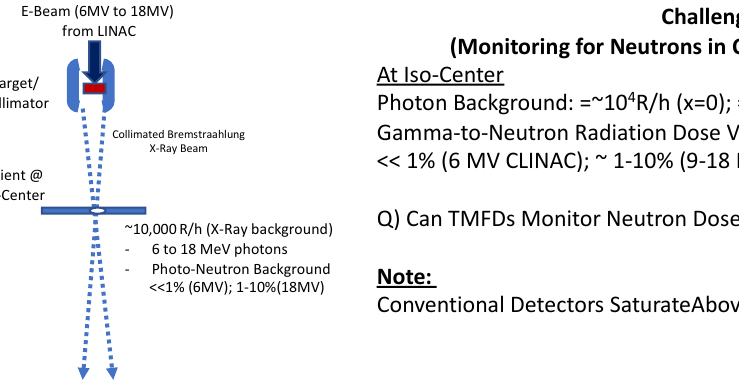
Figure 3. Schematic of extremely high photon fields and low-to-high neutron radiation field monitoring in medical clinical linear accelerators (CLINACs, commonly used worldwide for cancer therapy).